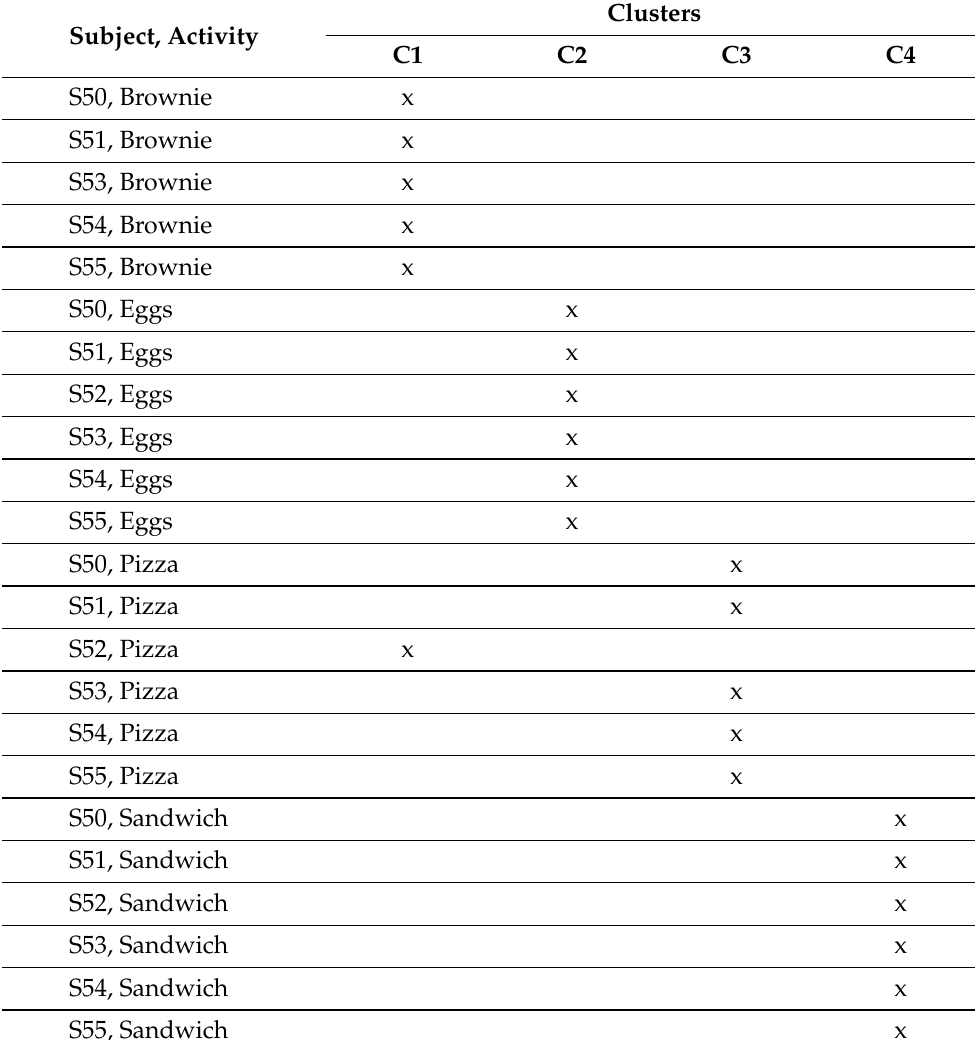
Table 3. Clustering results, when the number of clusters is given beforehand, obtained by IBC2 algorithm using CMU-MMAC database.